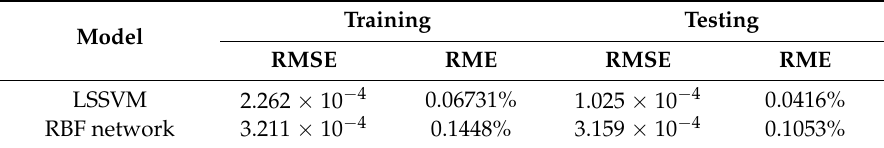
Table 2. The performance statistics of least squares support vector machine (LSSVM) model and radial basis function (RBF) network model during training and testing periods.